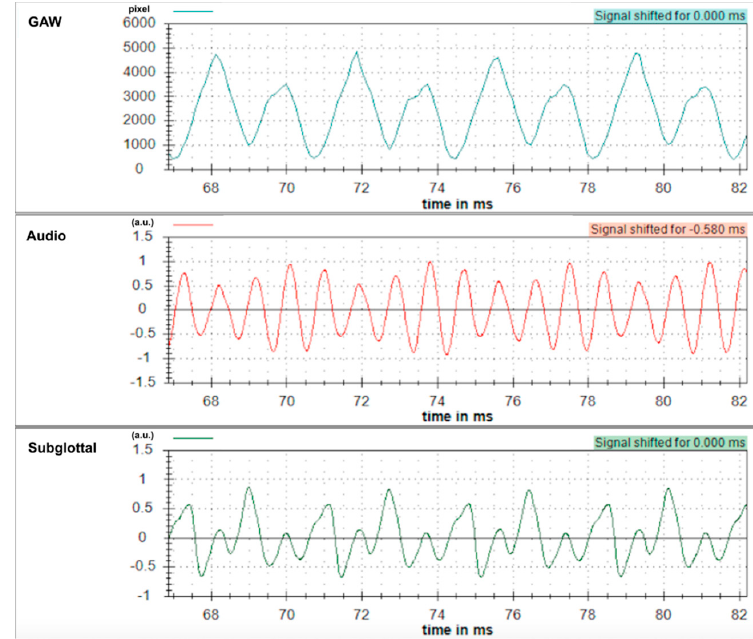
Figure 5. GAW, audio signal, subglottal frequencies in subharmonic vocal fold vibrations with two harmonics in the GAW.